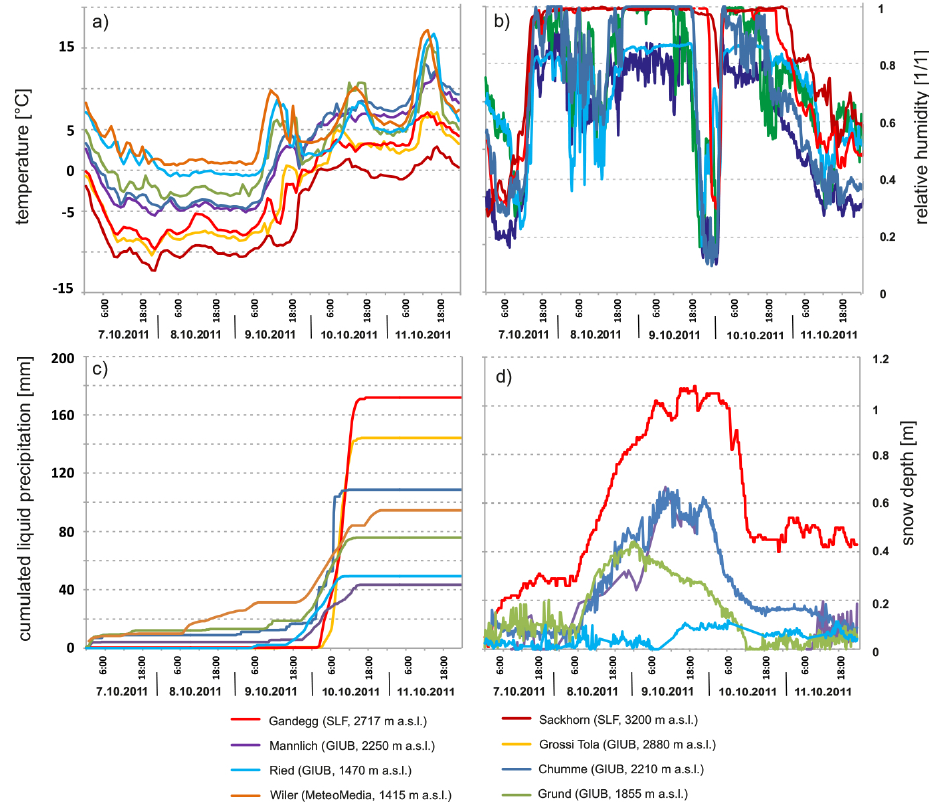
Figure 4. Temperature (a) , relative humidity (b) , accumulated liquid precipitation (c) , and snow height (d) measured at eight meteorological stations in the Lötschen Valley. The time series describe the overall course of the weather and reveal strongly heterogeneous rainfall